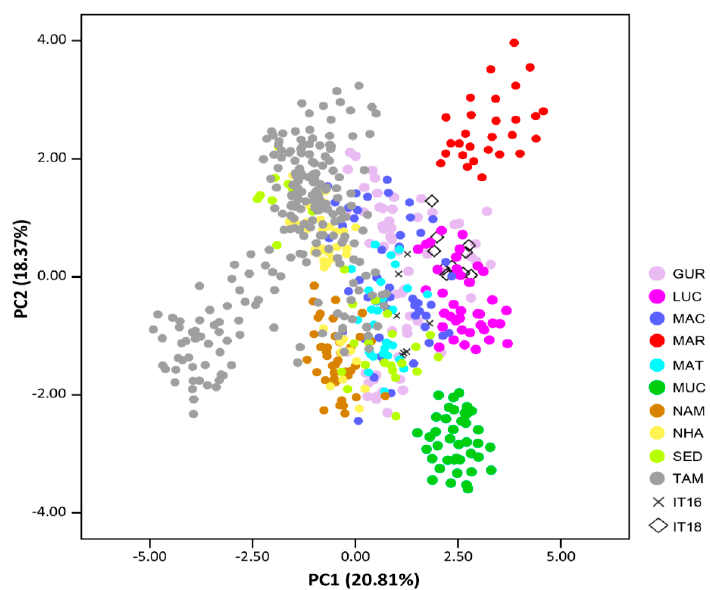
Figure 5. Distribution of the 610 cowpea specimens, according to the first and second principal components. The different colors indicate the landraces following Table 1. The two cultivars are also indicated.